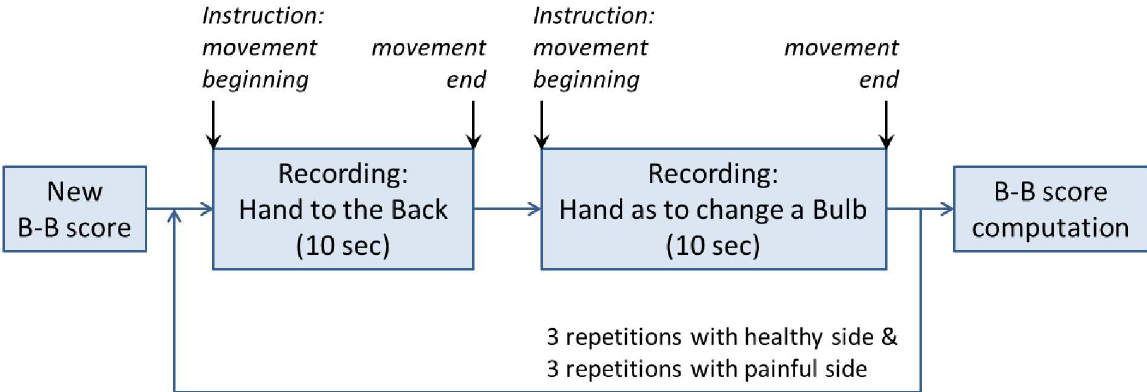
Fig 1. Schema of the application steps for the recording of a B-B score. From: Pichonnaz C, Duc C, Gleeson N, Ancey C, Jaccard H, Lecureux E, et al. Measurement Propertiesof the Smartphone-Based B-B Score in Current ShoulderPathologies.Sensors (Basel).